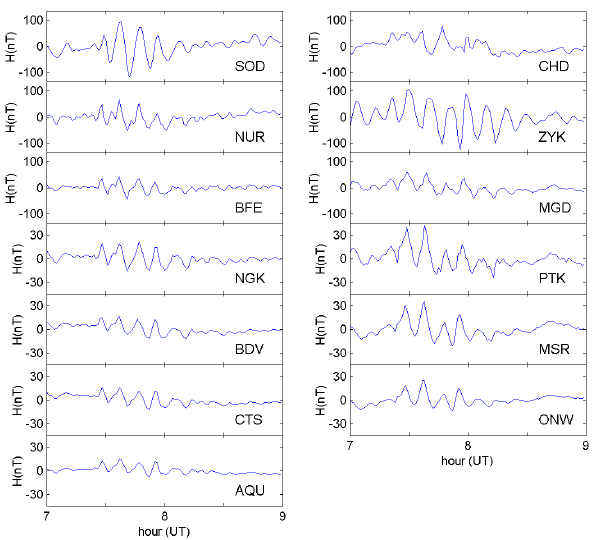
Fig. 3. Oscillations of the horizontal geomagnetic field H compo- nent in the time interval 07:00–09:00UT at the different stations.